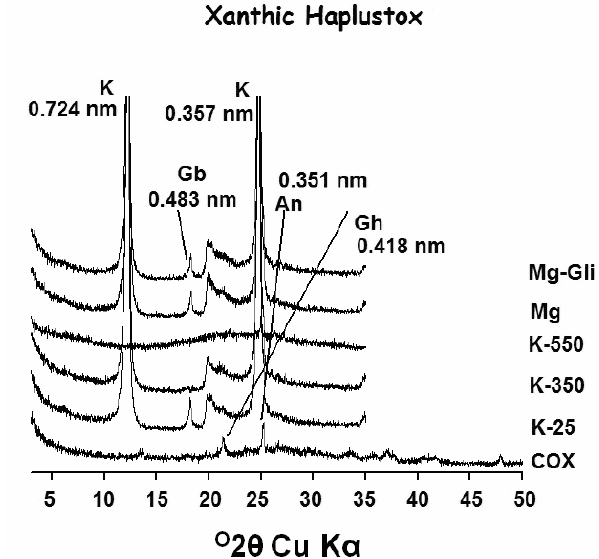
Figure 3. X ray diffractograms of the deferrified clay fraction of the Bw horizon of the Xanthic Haplustox (LA). K: Kaolinite, Gb: Gibbsite, Gh: Goethite, and An: Anatase.